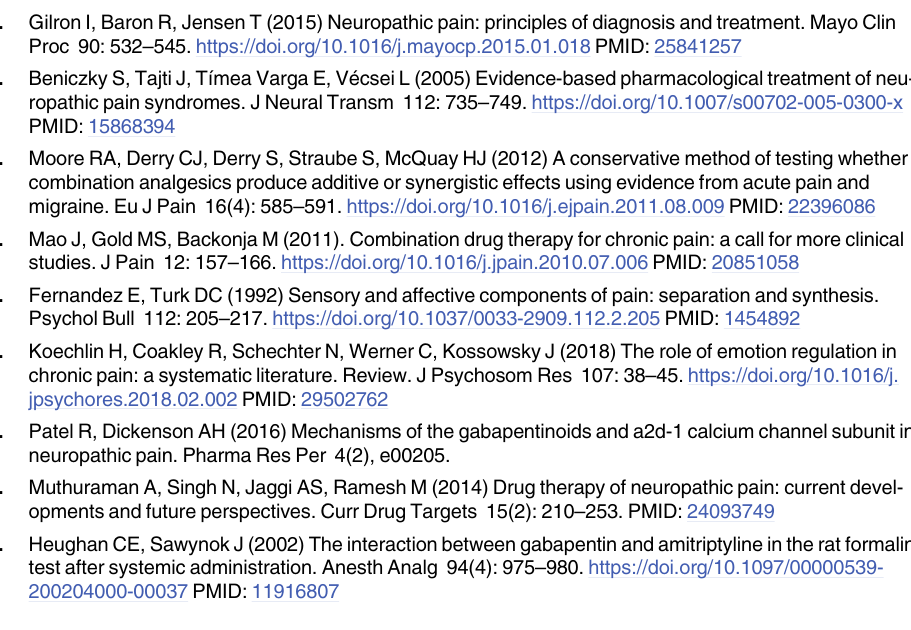
S2 Fig. Effect of gabapentin intraperitoneal administration on mechanical hyperalgesia 3 (A), 7 (B) and 14 (C) days following rat sciatic nerve ligation. The results are expressed as pain threshold (in grams) recorded 1 h after treatment administration. ##P < 0.01, ###P < 0.001 vs na ï ve group; � P < 0.05 vs vehicle CCI group. n = 6 animals/group. (TIF) S3 Fig. Effect of trazodone-gabapentin combination on mechanical hyperalgesia 3, 7 and 14 days following rat sciatic nerve ligation. The results are expressed as pain threshold (in grams) recorded 1 h after treatment administration. ###P < 0.001 vs na ï ve group; � P < 0.05, ��� P < 0.001 vs vehicle CCI group. n = 6 animals/group. (TIF) S1 Table. Pharmacokinetic parameters for trazodone and gabapentin.